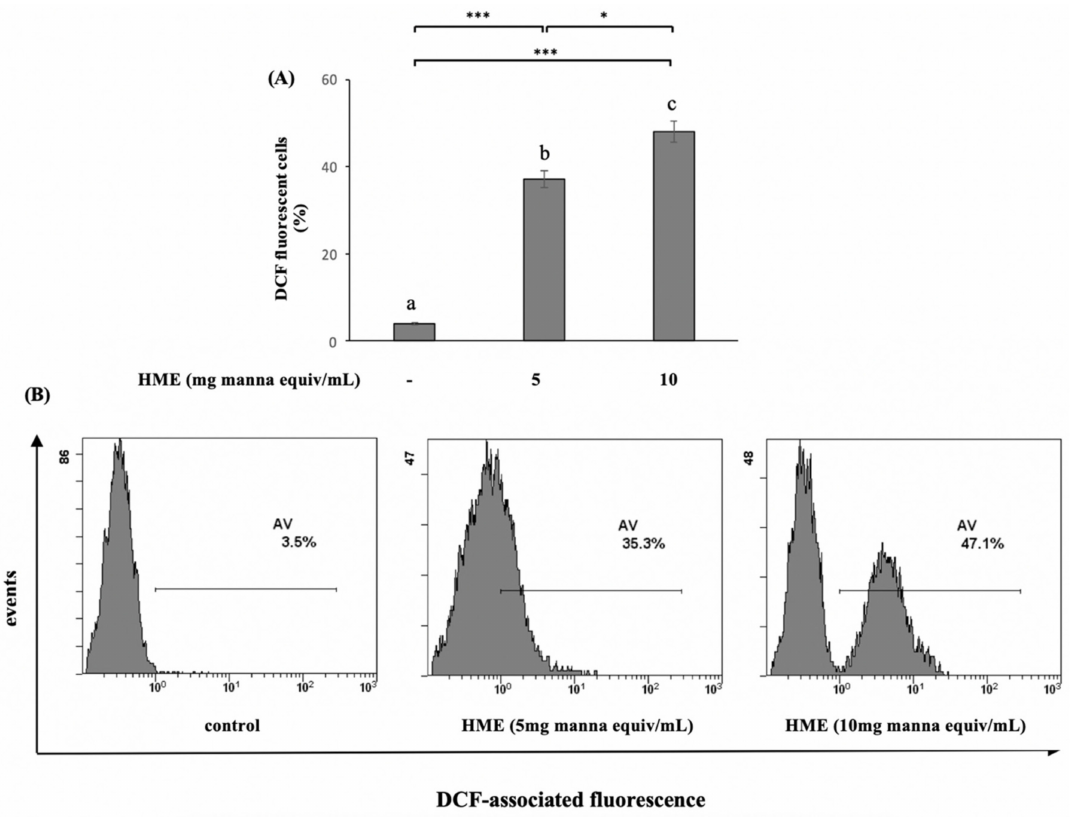
Figure 4. ROS production induced by HME on HCT-116 cells. ROS levels were cytofluorimetrically evaluated after 24 h treatment by staining of the cells with DCFDA as reported in Methods. Data are compared to untreated cells (control). ( A ) Mean values ± SD of three separate experiments in triplicate. Means with di ff erent letters are significantly di ff erent (one-way Anova associated with Tukey’s post hoc test) with * p < 0.05; *** p < 0.001. ( B ) Representative